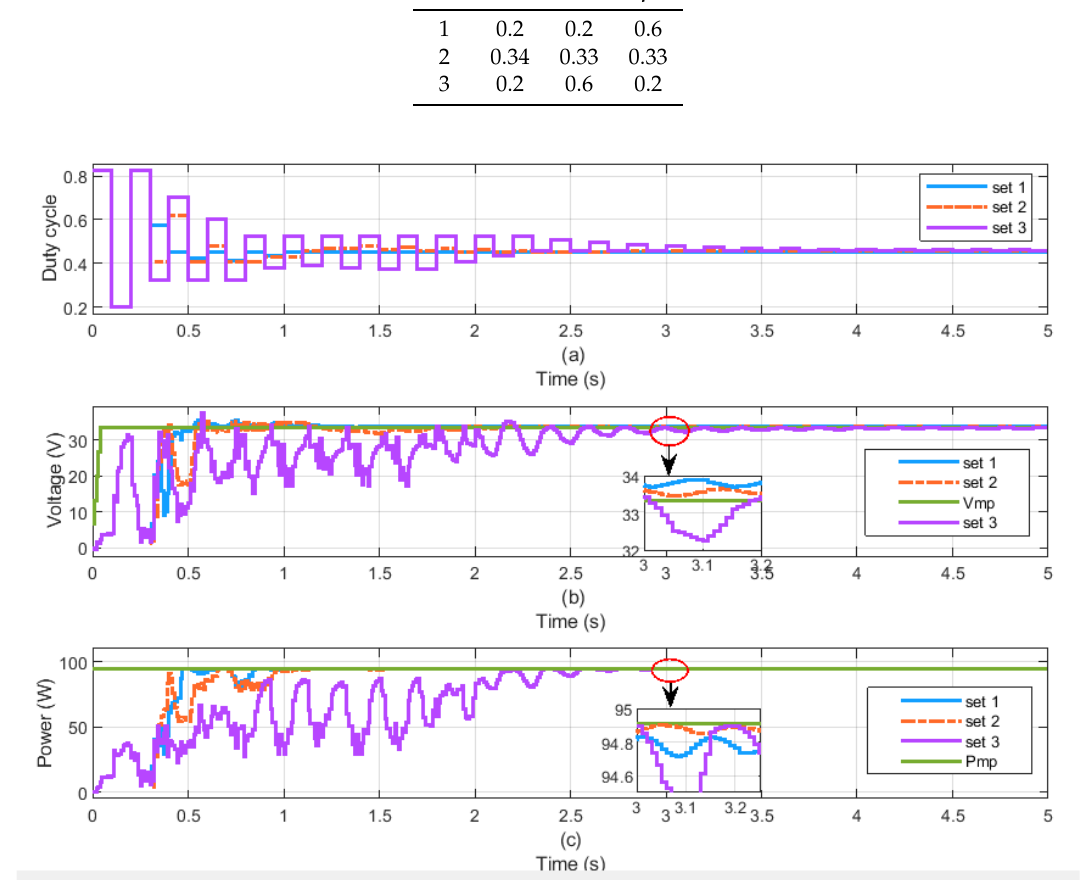
Figure 3. Simulation results under different sets of parameters w , α and β given by PSO algorithm at constant irradiance and temperature ( G = 800 W/m 2 , T c = 25 ◦ C): ( a ) duty cycle, ( b ) voltage, and ( c )